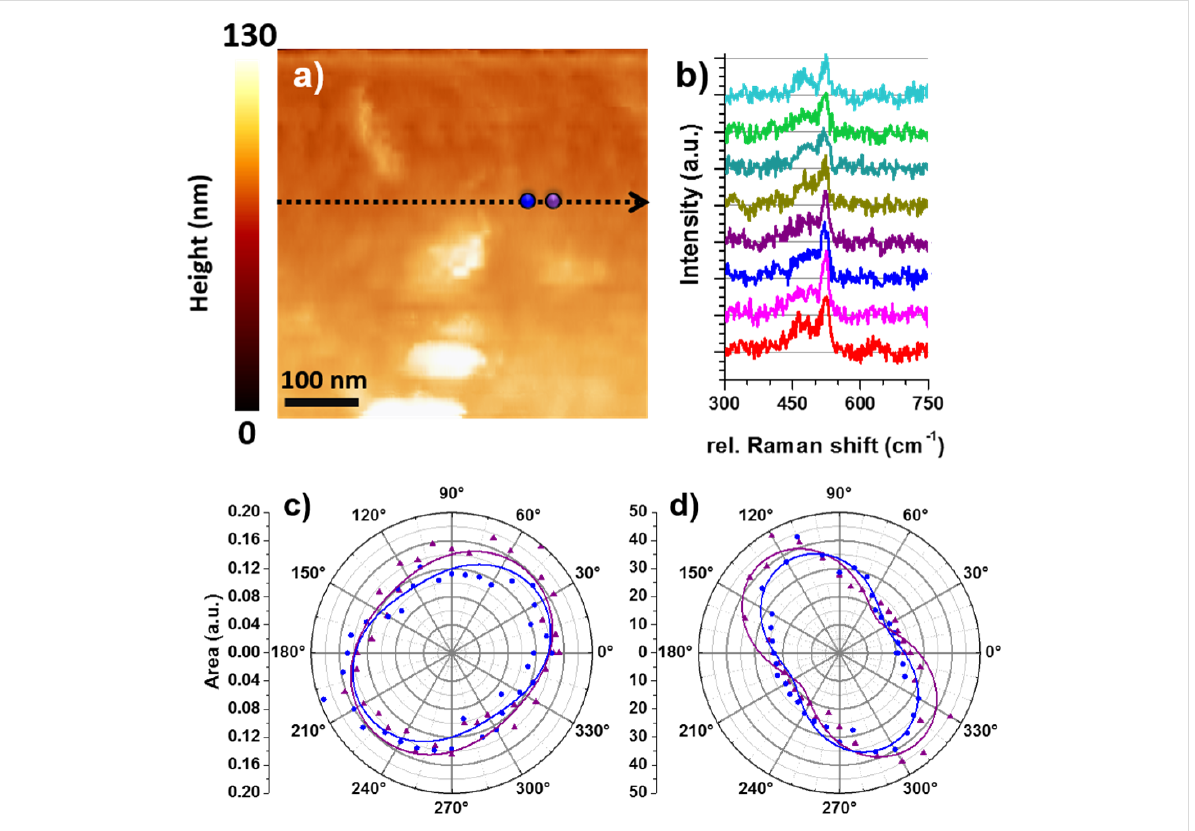
Figure 6: a) Topographical image of the top of a SiNW. The dashed arrow shows the region in which the 32 Raman spectra were recorded. The blue and the purple dot indicate the positions where the polarization angle-resolved measurements where performed. b) Eight of the collected Raman spectra along the white arrow in panel a showing varying c-Si Raman peak intensities. A detailed analysis about the intensity evolution of the a-Si and c-Si Raman peaks is shown in Figure S2 (Supporting Information File 1). c) Polarization angle-resolved Raman scattering of the c-Si Raman peak as a function of the rotation angle of the Glan–Taylor polarizer. The triangles and circles are the original data, whilst the closed lines are to guide the eyes. d) Polarization angle-resolved photoluminescence patterns collected from the same sample positions, indicated in panel